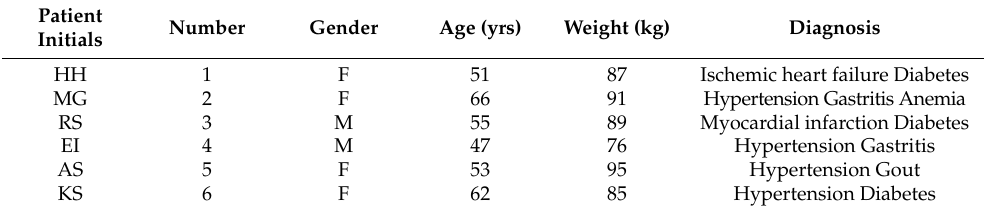
Table 7. Patients’ data (patient number, gender, age, weight and